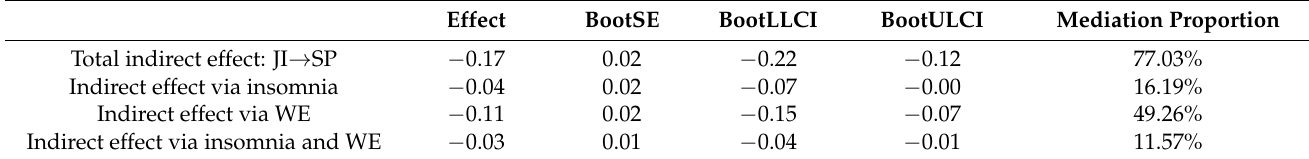
Table 5. Indirect effects of job insecurity on safety participation based on 5000 bias-corrected bootstrapped